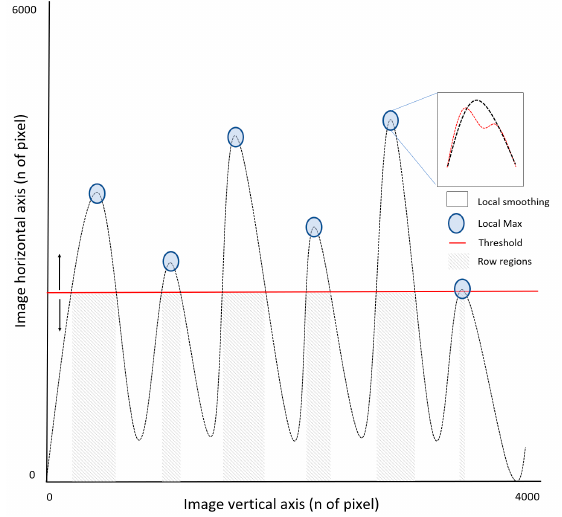
Figure 3. Diagram of the Excess Greenness (ExG) index projection, local-maxima smoothing, and thresholding for rows location.